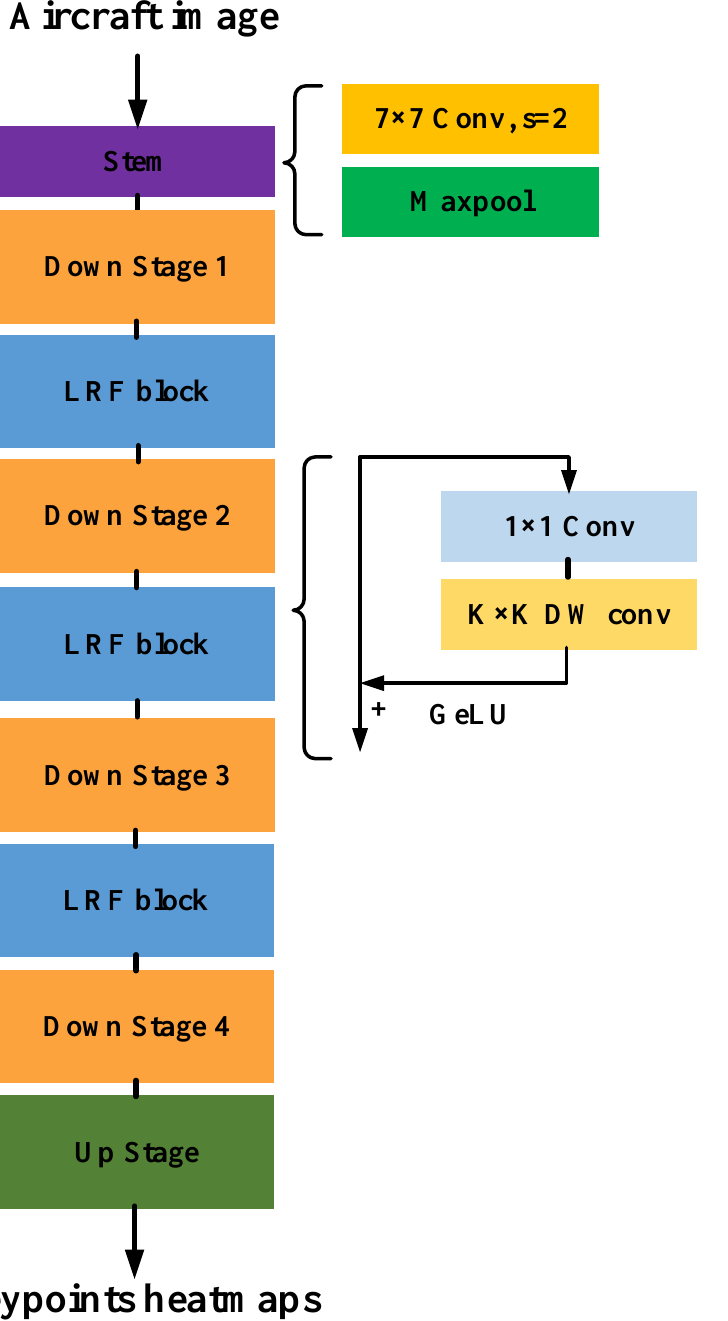
Figure 6. Aircraft